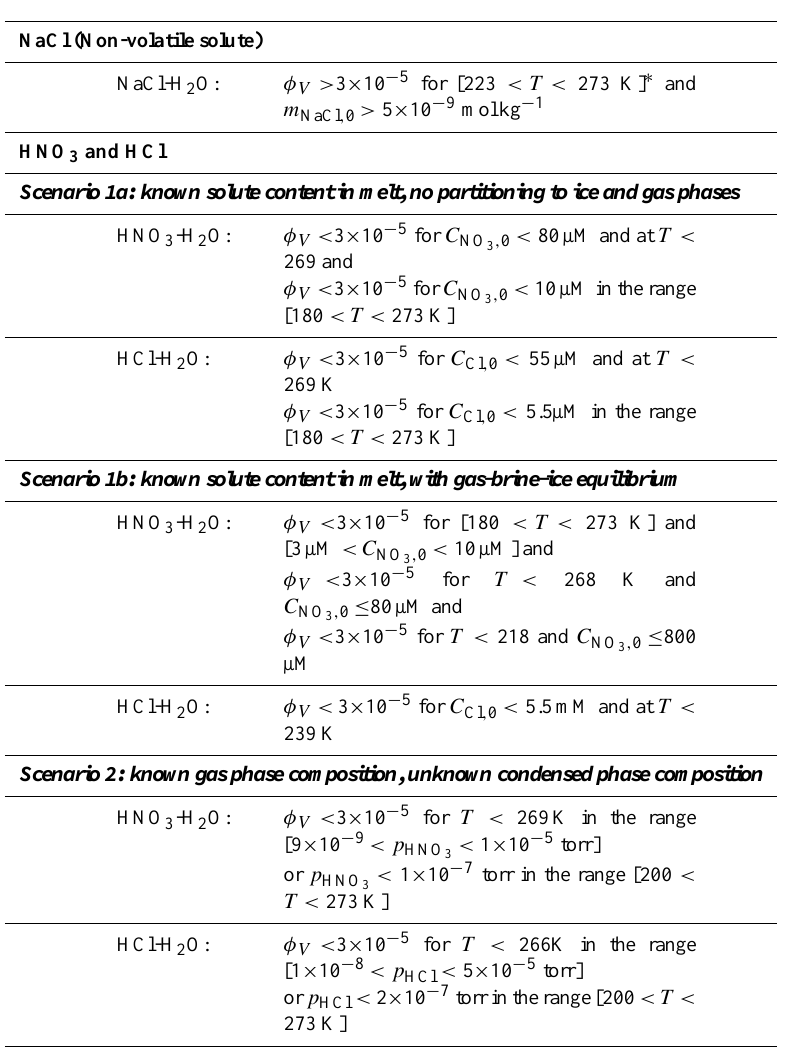
Table 1. Conditions for which the brine volume fraction, ϕ V , is less than 3 × 10 − 5 as predicted by the model under various scenarios. This cutoff value of ϕ V corresponds to a brine layer of 10nm on a sphere with radius